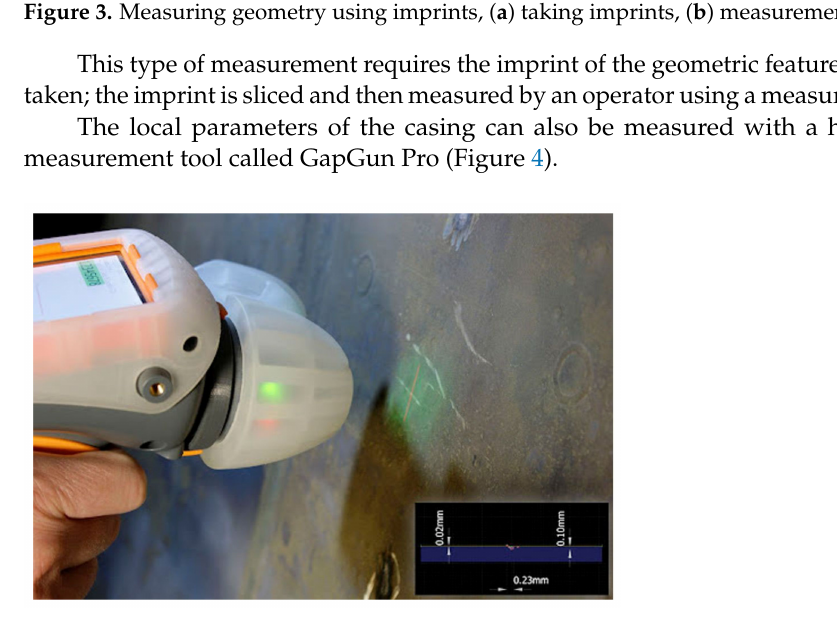
Figure 4. GapGun Pro hand-held laser measurement